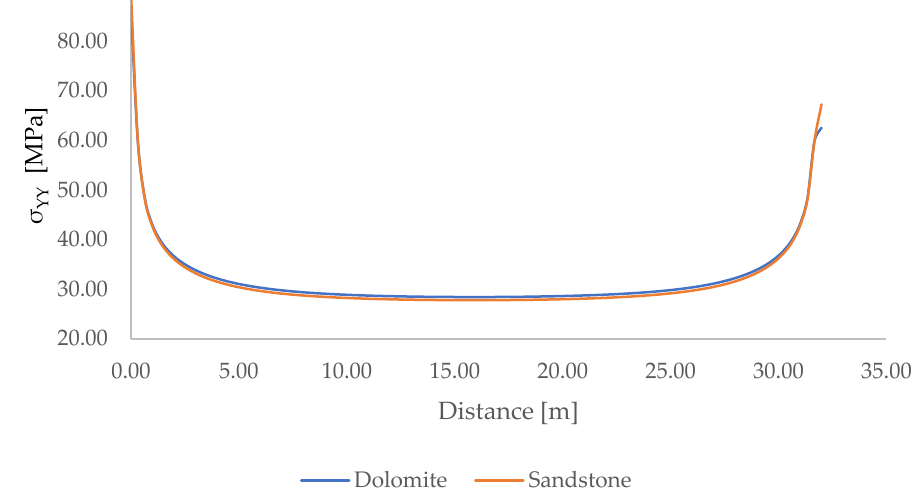
Figure 13. Distribution of σ YY stresses acting on the protective pillars in the cross-section through the entries.